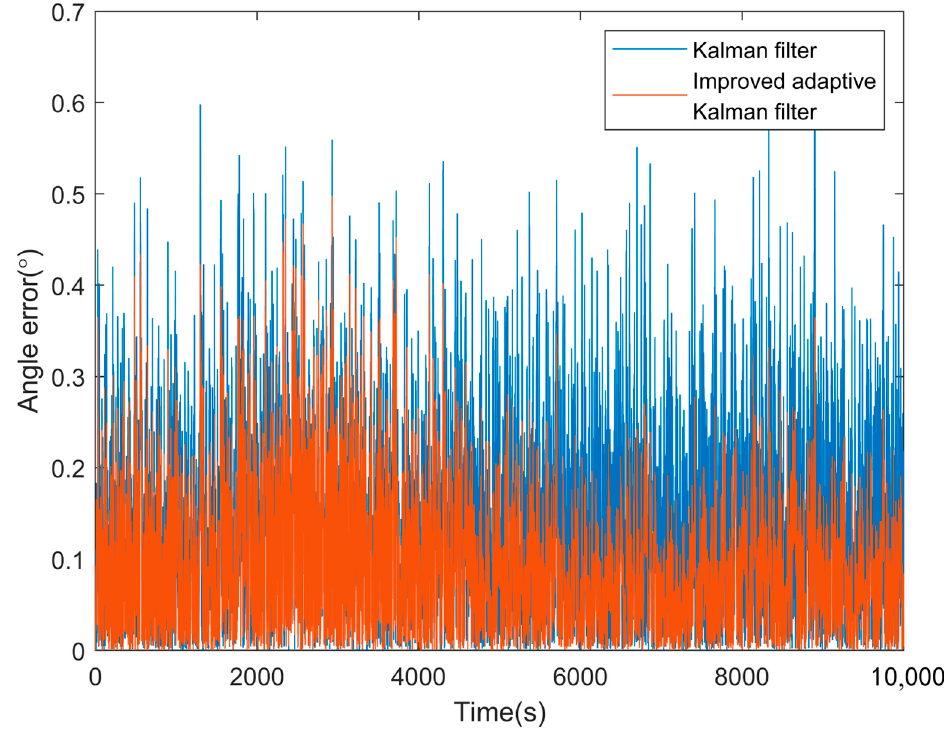
Figure 12. Filtering error of the IAKF sowing monomer attitude angle.